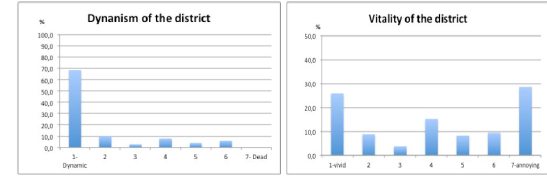
Fig. 14. Evaluation of dynamism and vitally trough sound heard within the